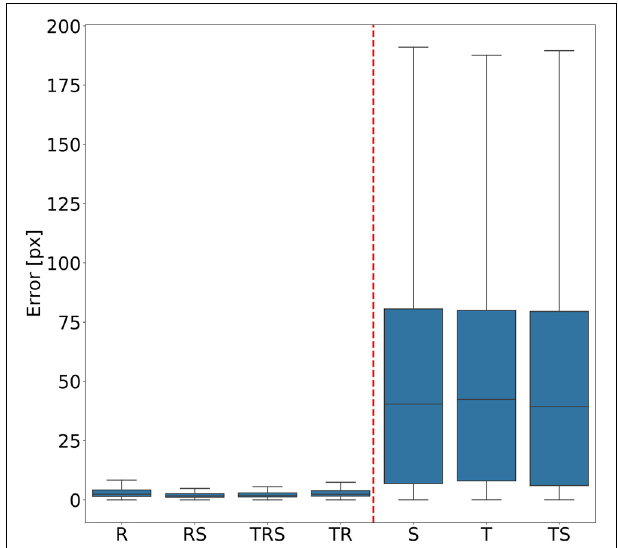
FIGURE 3 | Rotation matters. Average pixel error of seven models that were trained with different combinations of scaling (S), rotation (R), and translation (T). Models that were trained with variable rotation of the posture (left: R, rotation with scaling (RS), translation, rotation and scaling (TRS), TR) outperform models that were trained with one posture orientation only (right: S, T, TS). Note that, for the sake of clarity, outliers beyond 1.5 times the interquartile range are not shown. As yet, all data points were included in any and all statistical computations. The scale factor converting pixels to mm was in the range of 0.18–0.55 mm/pixel, depending on the scaling factor of the random transformation.